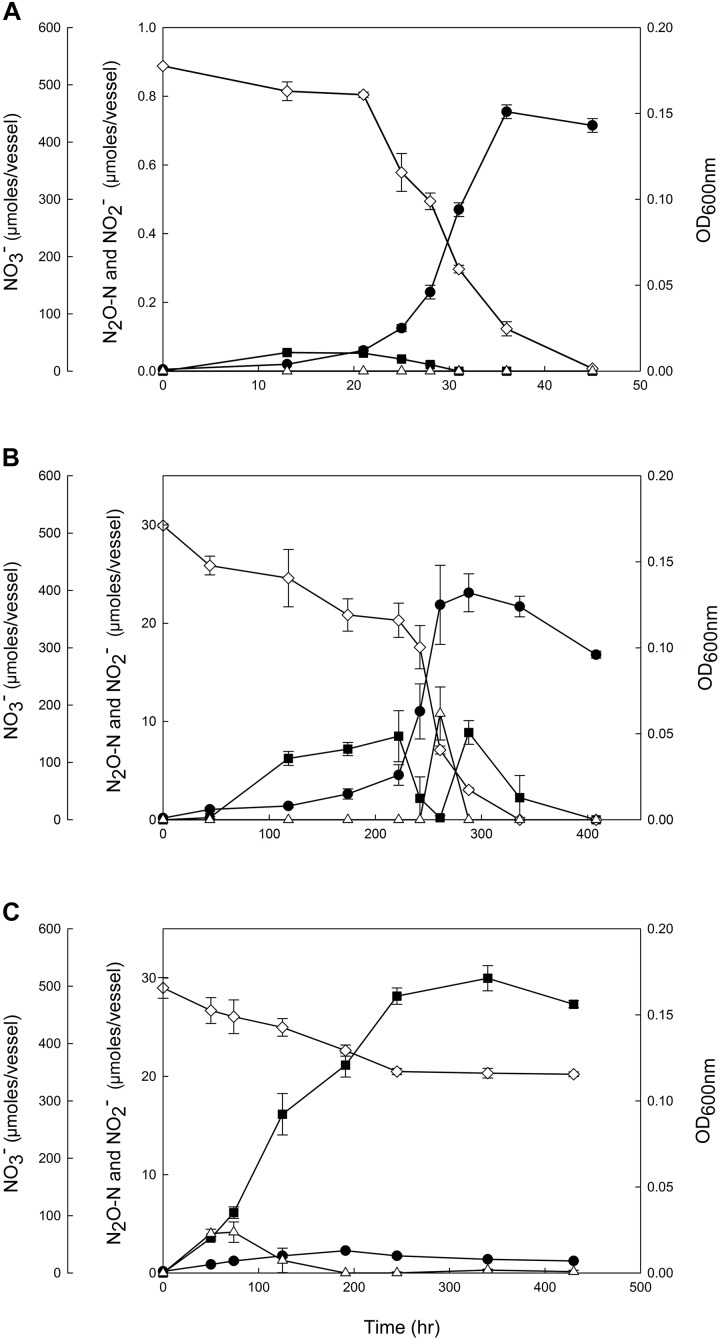
Reduction of 5 mM NO3− by the denitrifying Dechloromonas aromatica RCB cultures incubated at (A) the control condition (0.05% w/v NaCl, pH 7.0), (B) the salt stress condition (0.70% w/v NaCl, pH 7.0) and (C) the alkaline stress condition (0.05% w/v NaCl, pH 8.0). The amounts of NO3− (), NO2− (Δ), and N2O-N () and the absorbances at 600 nm () were monitored until the nitrogen oxides were depleted or upon confirmation of the termination of denitrification reaction. Each reaction vessel is a 160 mL serum bottle with the initial aqueous phase volume of 100 mL. The data points represent the averages of triplicate cultures and the error bars the standard deviations of the triplicate measurements.